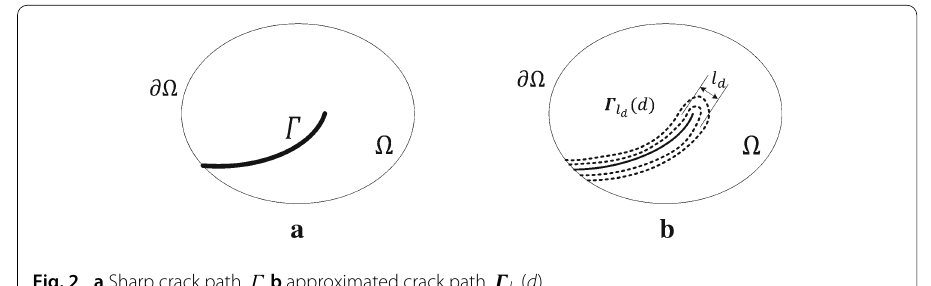
Fig. 2 a Sharp crack path, Γ b approximated crack path, Γ l